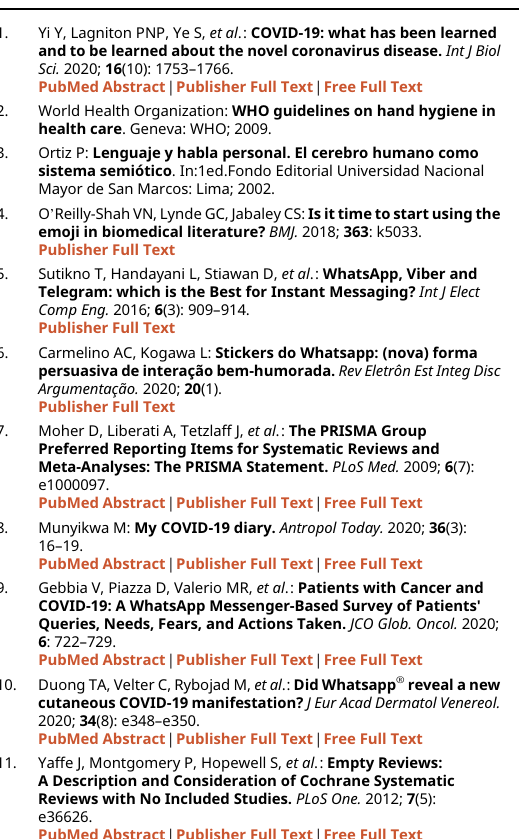
Figshare: PRISMA checklist for ‘ Other ways of communicating the pandemic: memes and stickers against COVID-19 ’ . https://doi.org/10.6084/m9.figshare.14204123.v1. 23 Data are available under the terms of the Creative Commons Zero “ No rights reserved ” data waiver (CC0 1.0 Public domain